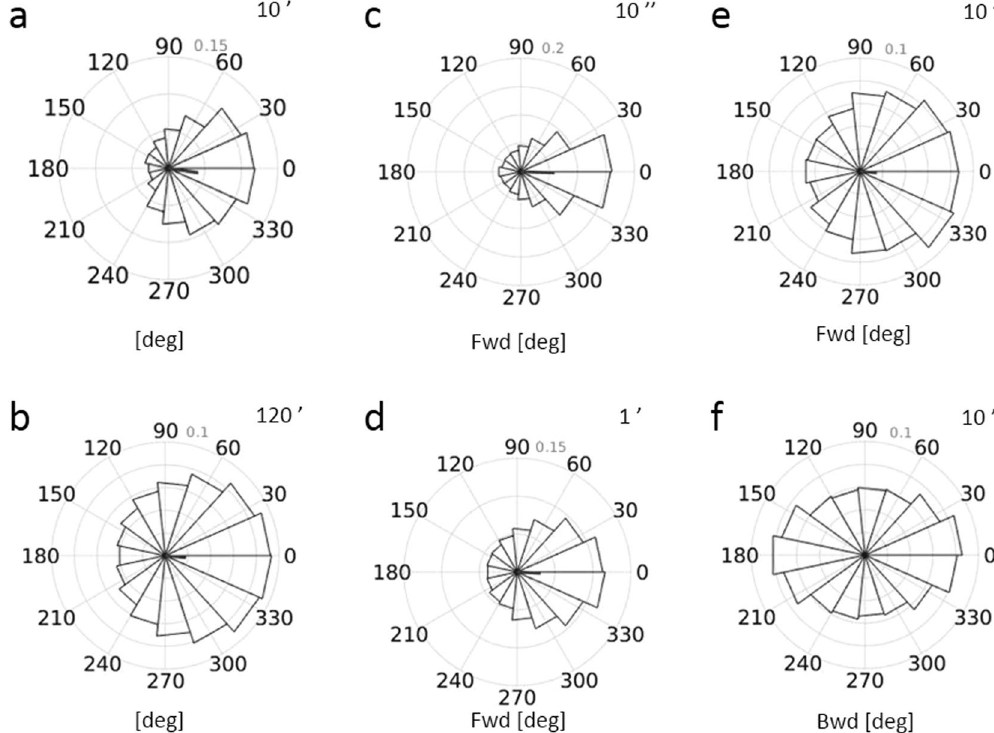
Figure 7. Cell orientation dynamics in the absence of chemoattractant. ( a , b ) Distribution of step angles over 10 minutes ( a ) or 120 minutes ( b ). The distributions are skewed to 0° (direction away from the well), especially at the beginning of the assay. ( c – f ) Distribution of step angles differences after an initial forward step ( c – e ), or backward step ( f ) for delay times of 10 seconds, 1 minute and 10 minutes, respectively. The results are representative for 8 independent experiments.